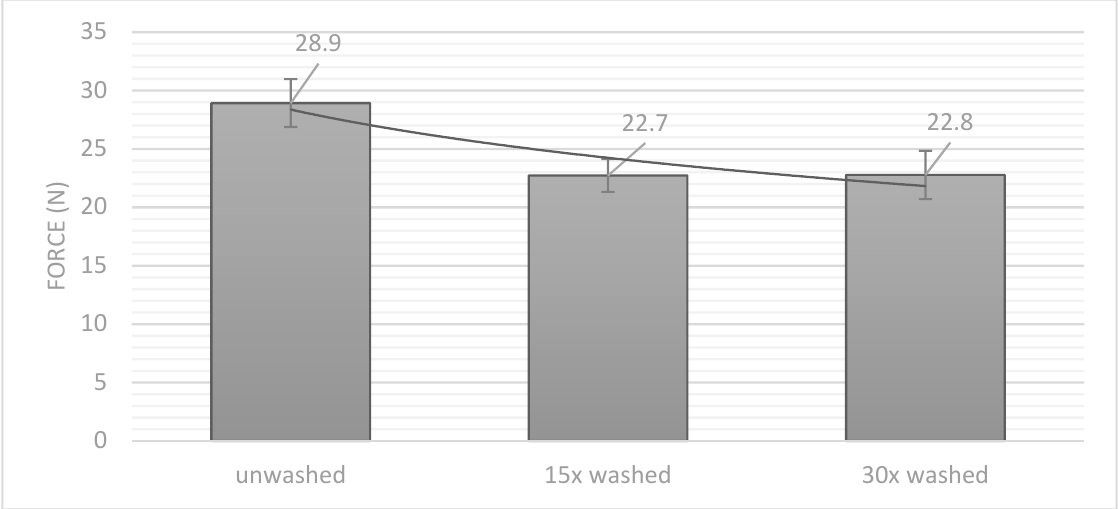
Figure 9. Peeling strength force after different washing cycles (black exponential trend line). Figure 10 illustrates the course of force during the peeling test for each sample. The graphs show an approximately uniform development. The washed samples demonstrated an irreducibly lower maximum force than the unwashed samples, but the course and the pitch angle were nearly the same. The results show the excellent mechanical properties of the joint. Both the unwashed and the washed samples demonstrated very high peel strengths. It can be concluded that the joints were hardly affected mechanically by the washing process. Figure 10 also shows that the maximum ductility of the joint decreased with the number of washing cycles. The entire structure thus became more